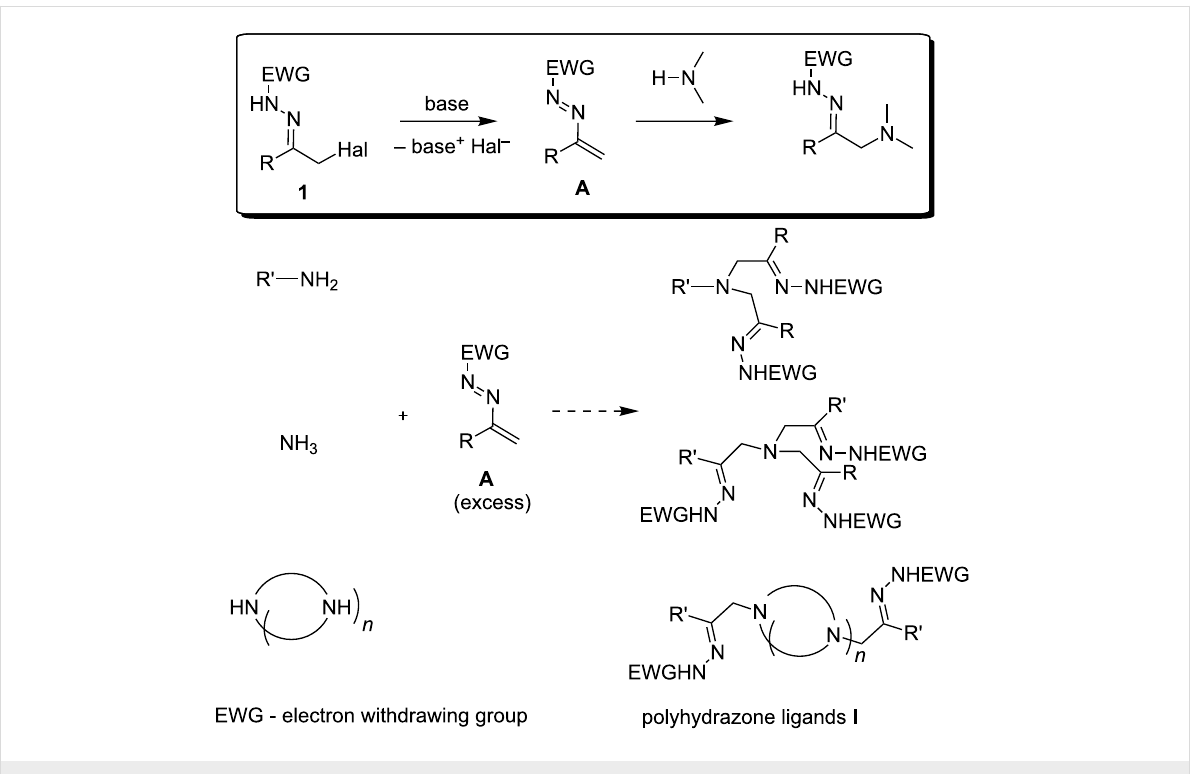
Scheme 1: Proposed approach to the synthesis of I .